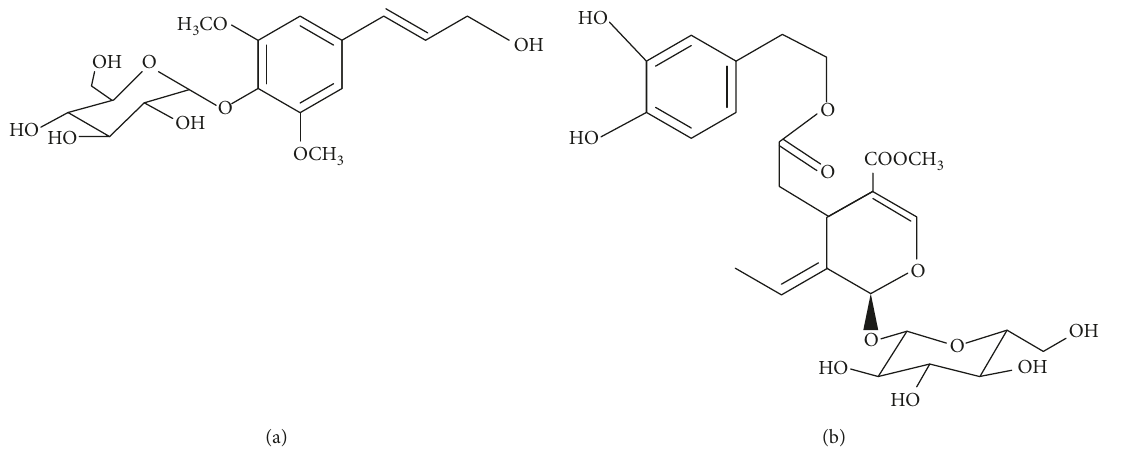
Figure 1: Chemical structure of (a) syringoside and (b)